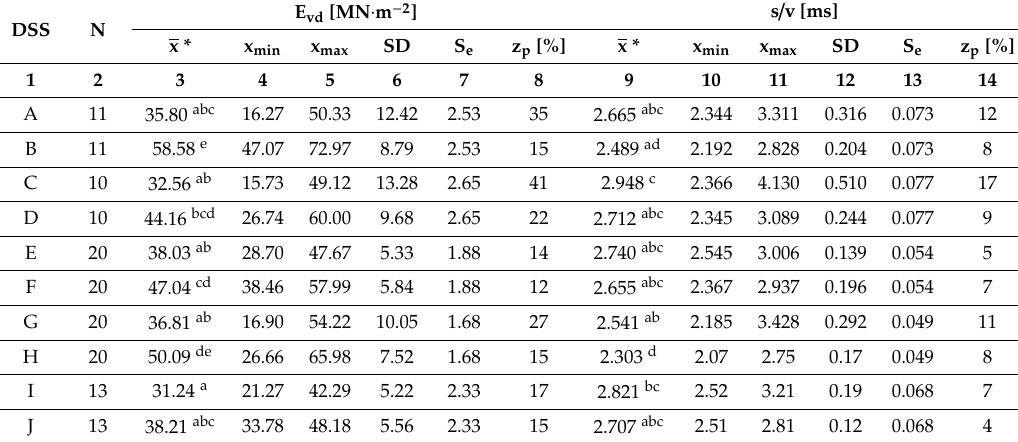
Table 4. The results of testing the bearing capacity with light weight deflectometer on the experimental road